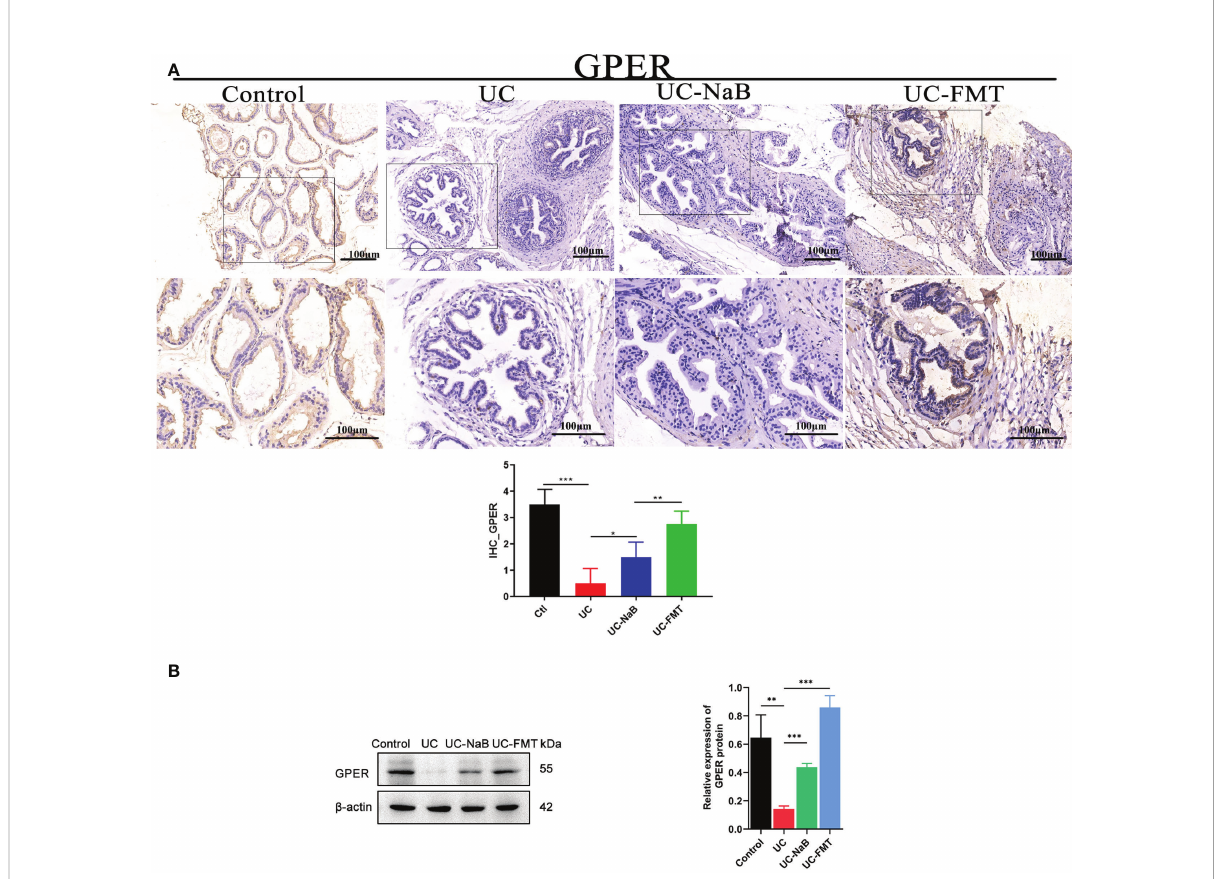
FIGURE 4 GPER expression in the prostate tissue. Immunohistochemistry (A) and western blot (B) analysis of proteins in the prostate tissue under different conditions. * p <0.05, ** p <0.01, *** p